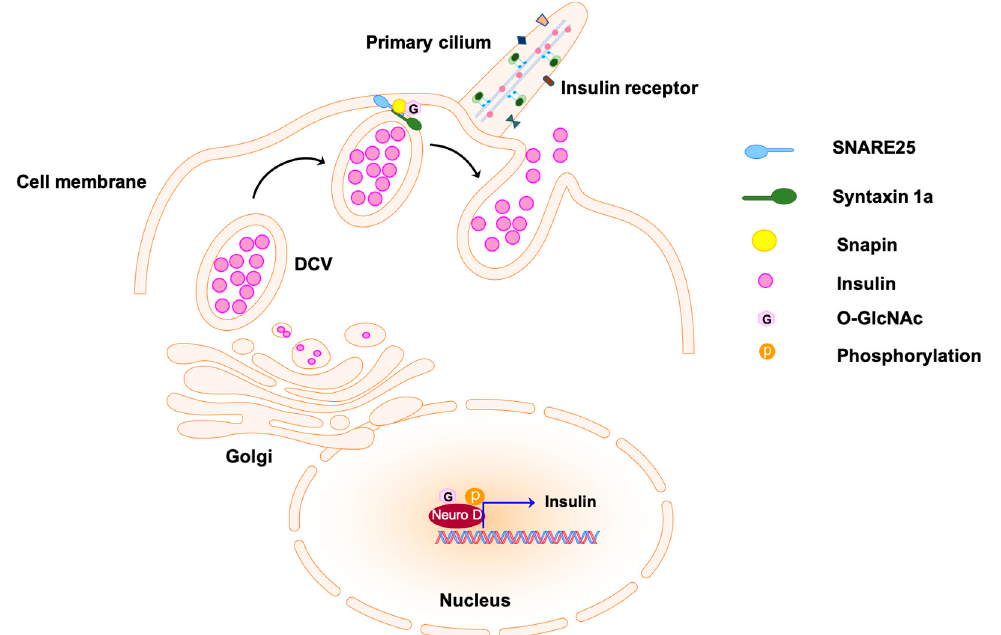
Figure 3. Insulin secretion from pancreatic β -cells by exocytosis. Transcription regulator Neuro D promotes the expression of insulin; it is enclosed in the dense core vesicles (DCVs) and secreted to the extracellular matrix via exocytosis. The docking of the exocytosis vesicles to the target membrane is mediated by the formation of complex SNARE25-Syntaxin1a at the first stage of insulin secretion. The O-GlcNAcylation of snapin, a subunit of the complex, is involved in the regulation of complex formation and vesicle fusion. The O-GlcNAcylated molecules are labeled with pink hexagons. SNARE25 indicates soluble N-ethylmaleimide-sensitive factor attachment protein receptor.